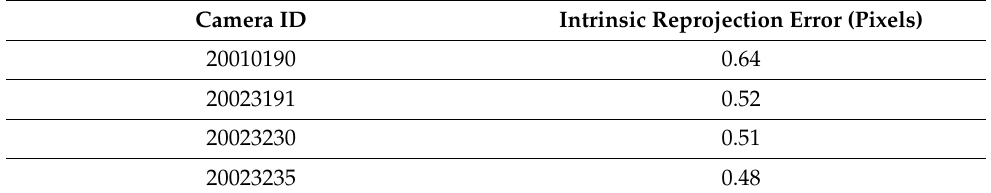
Table A4. Reprojection error in pixels after camera-intrinsic and -extrinsic parameter calibration.